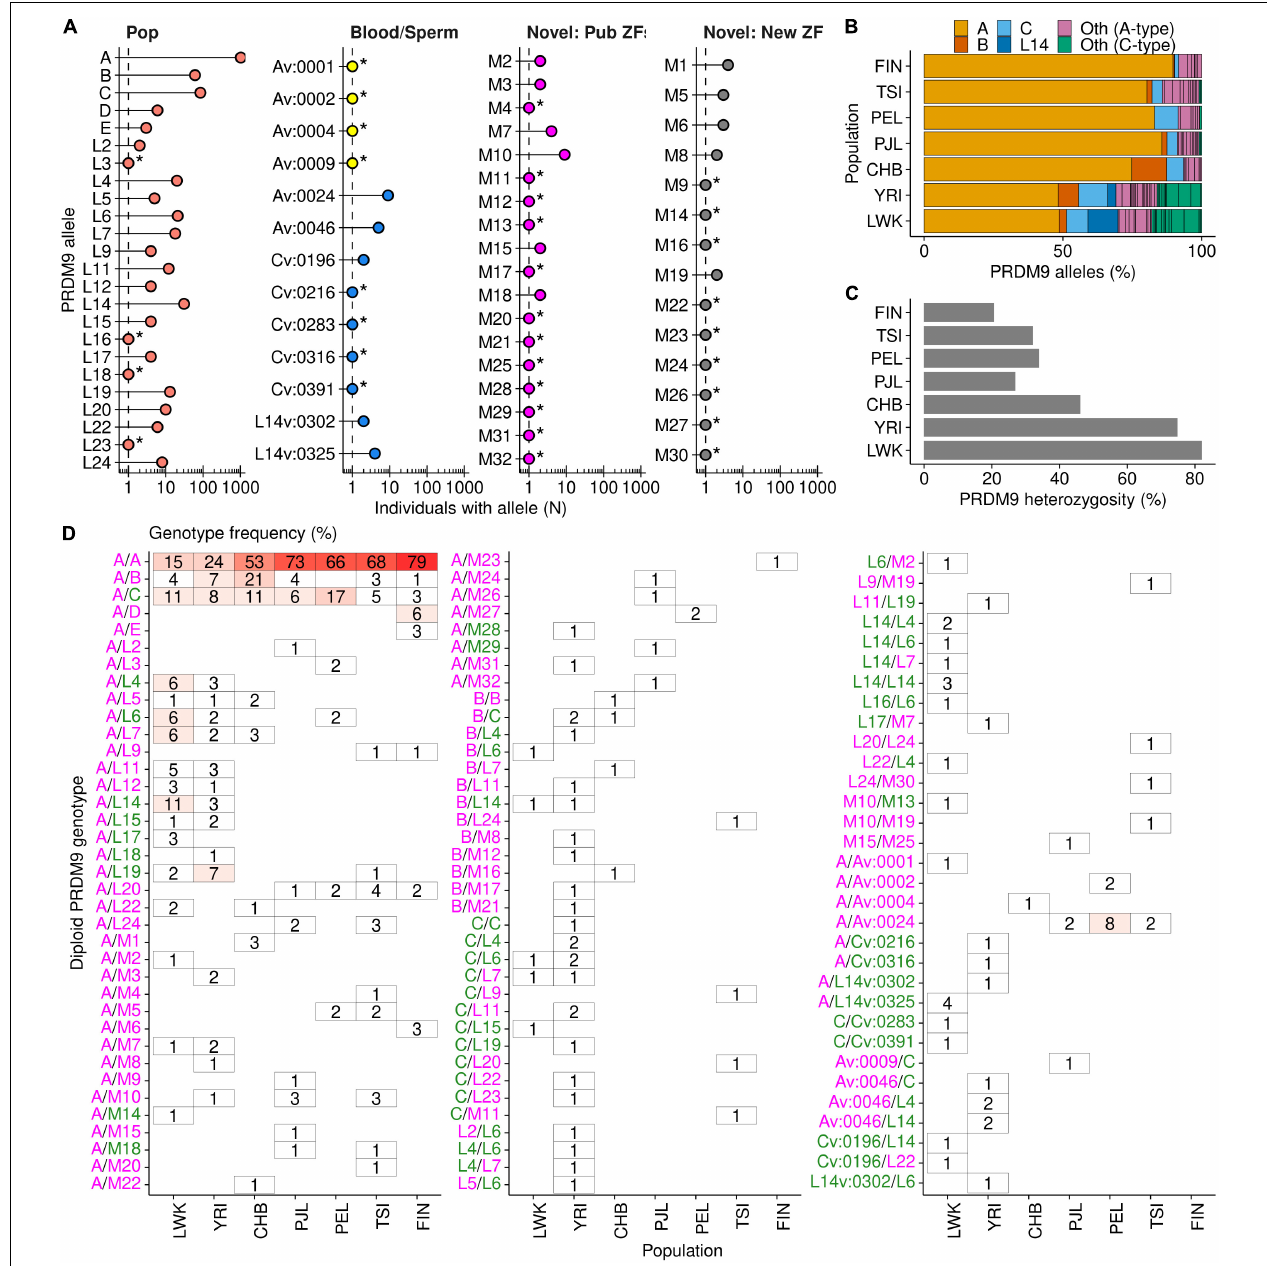
FIGURE 2 | PRDM9 diploid genotypes in seven populations. Sixty-nine total PRDM9 alleles were found in 720 individuals. (A) Approximately half of the PRDM9 alleles sequenced in this study are found in > 1 individual [asterisk (*) denotes alleles found in one individual]. Alleles are split by type; Pop (red) = PRDM9 allele found in previous population studies; Sperm/Blood = found as a PRDM9 variant in blood (yellow) or sperm (blue); Novel: Pub ZFs (pink) = novel PRDM9 allele identified in this study and contains only known ZFs; Novel: New ZF (gray) = novel PRDM9 allele identified in this study and contains at least one new ZF. (B) Composition of PRDM9 alleles in each population. The four most prevalent alleles are color coded ( A —yellow; B —orange; C —light blue; L14 —dark blue). All other alleles are color coded by A -type or C-type allele (described in Supplementary Figure S4 ; A -type = magenta and C -type = green). (C) Frequency of PRDM9 heterozygosity in each population. (D) Frequency of diploid PRDM9 genotypes in each population. Blank spaces indicate genotypes not found. A -type allele labels are magenta and C -type are green.